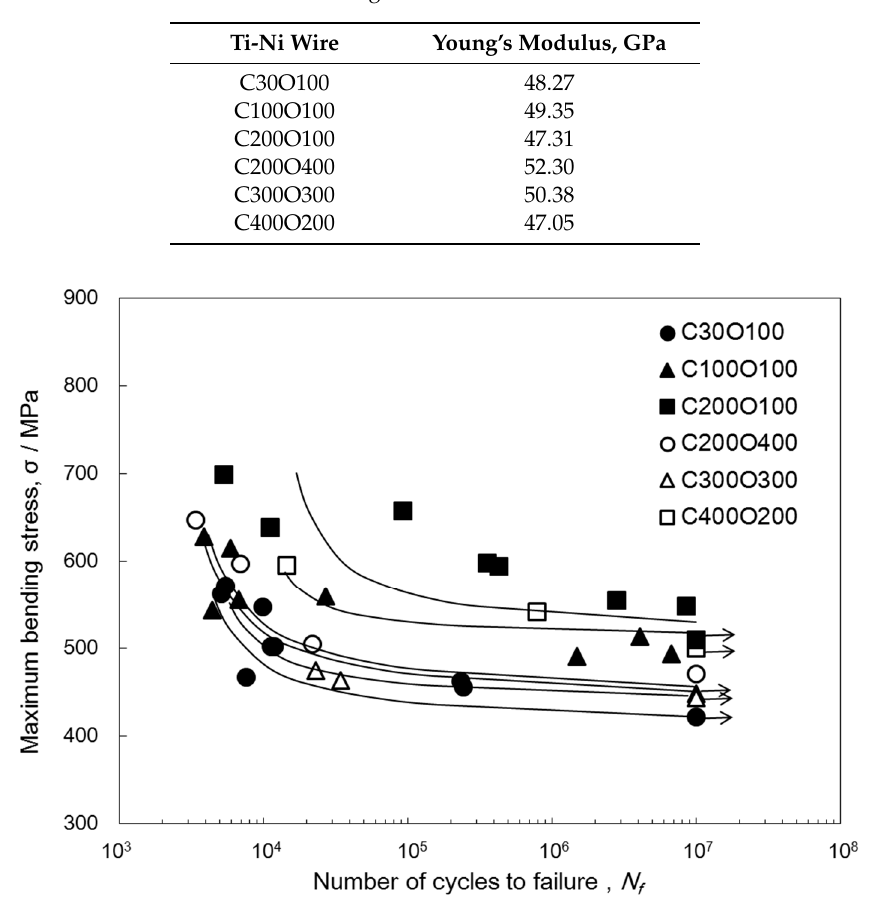
Figure 6. Fatigue curves of C30O100, C100O100, C200O100, C200O400, C300O300, and C400O200 wires in rotating bending fatigue tests in Hanks’ solution kept at 37 °C. Arrows indicate no failure after 10 7 cycles in the tests.